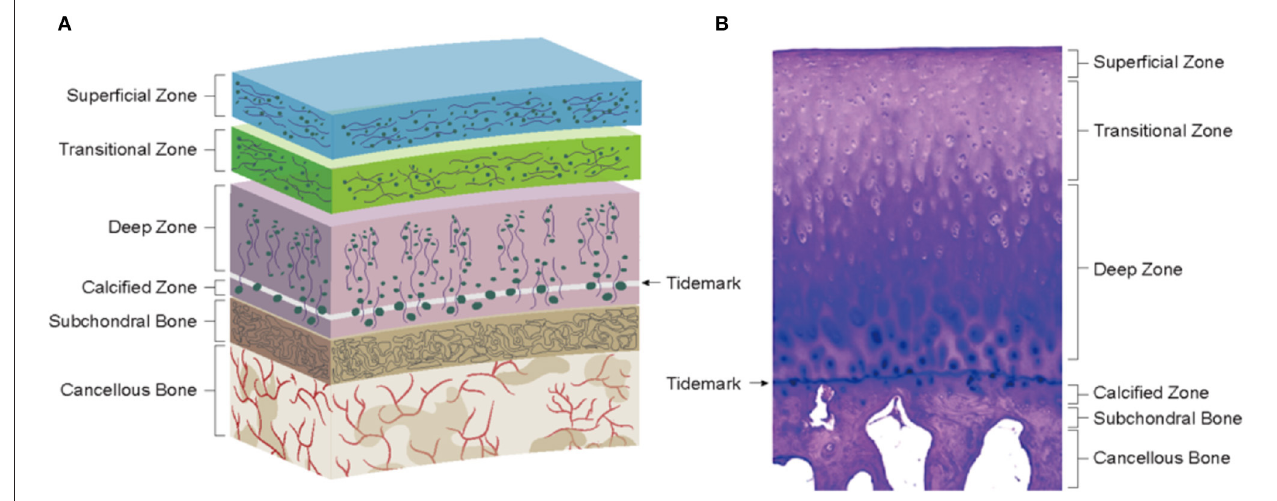
FIGURE 2 | Physiological environment of healthy cartilage. (A) Schematics of cartilage zonal structure. (B) Histology of healthy cartilage (Loeser et al.,